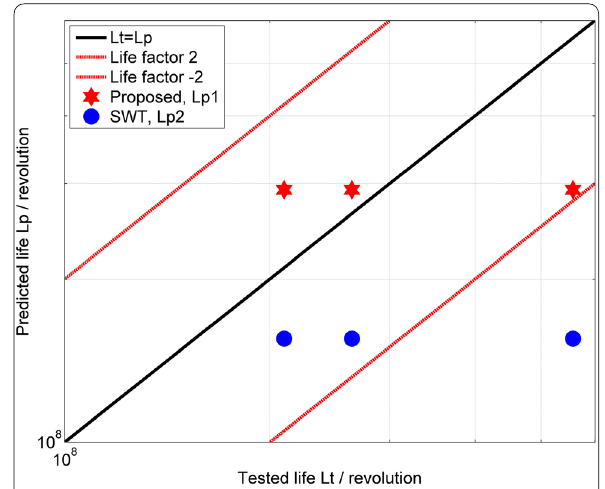
Figure 18 Predicted life vs. the tested life of the rolling bearing